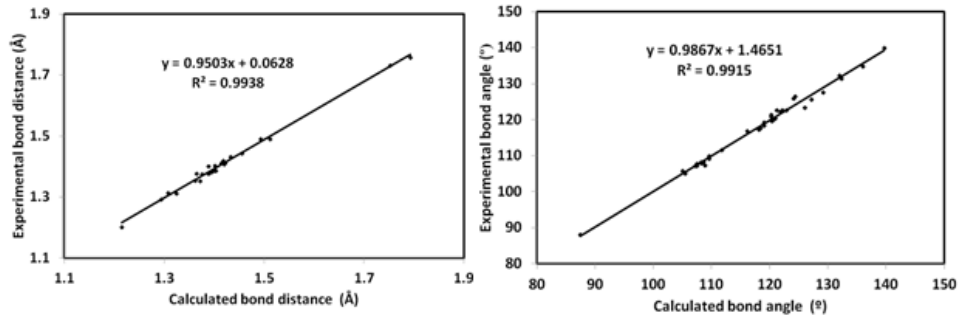
Figure 9. Correlation graphs between the experimental data (bond angles and bond distance) and calculated data.